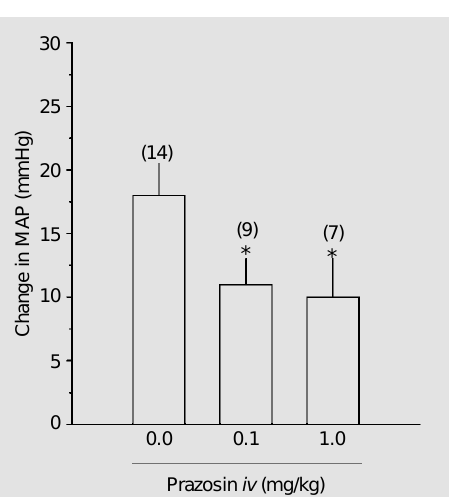
Figure 3. Effect of intravenous injection of prazosin on the pres- sor response to icv losartan (90 µg). The number of animals is given in parentheses. *P<0.05 vs doze zero (Student-Newman- Keuls test). MAP = mean arterial